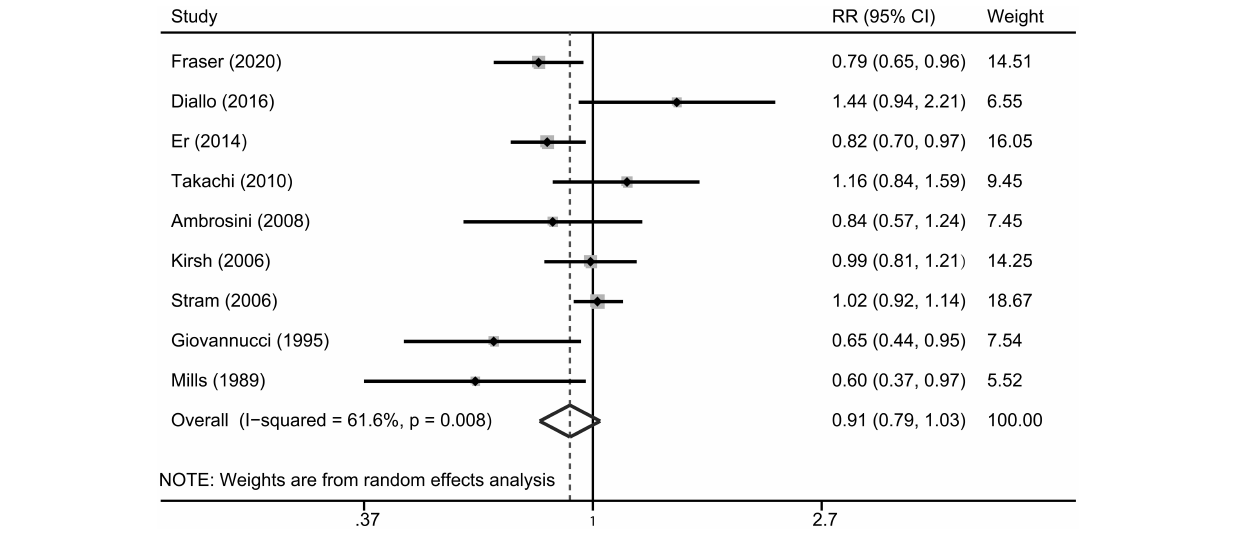
Frontiers in Nutrition |